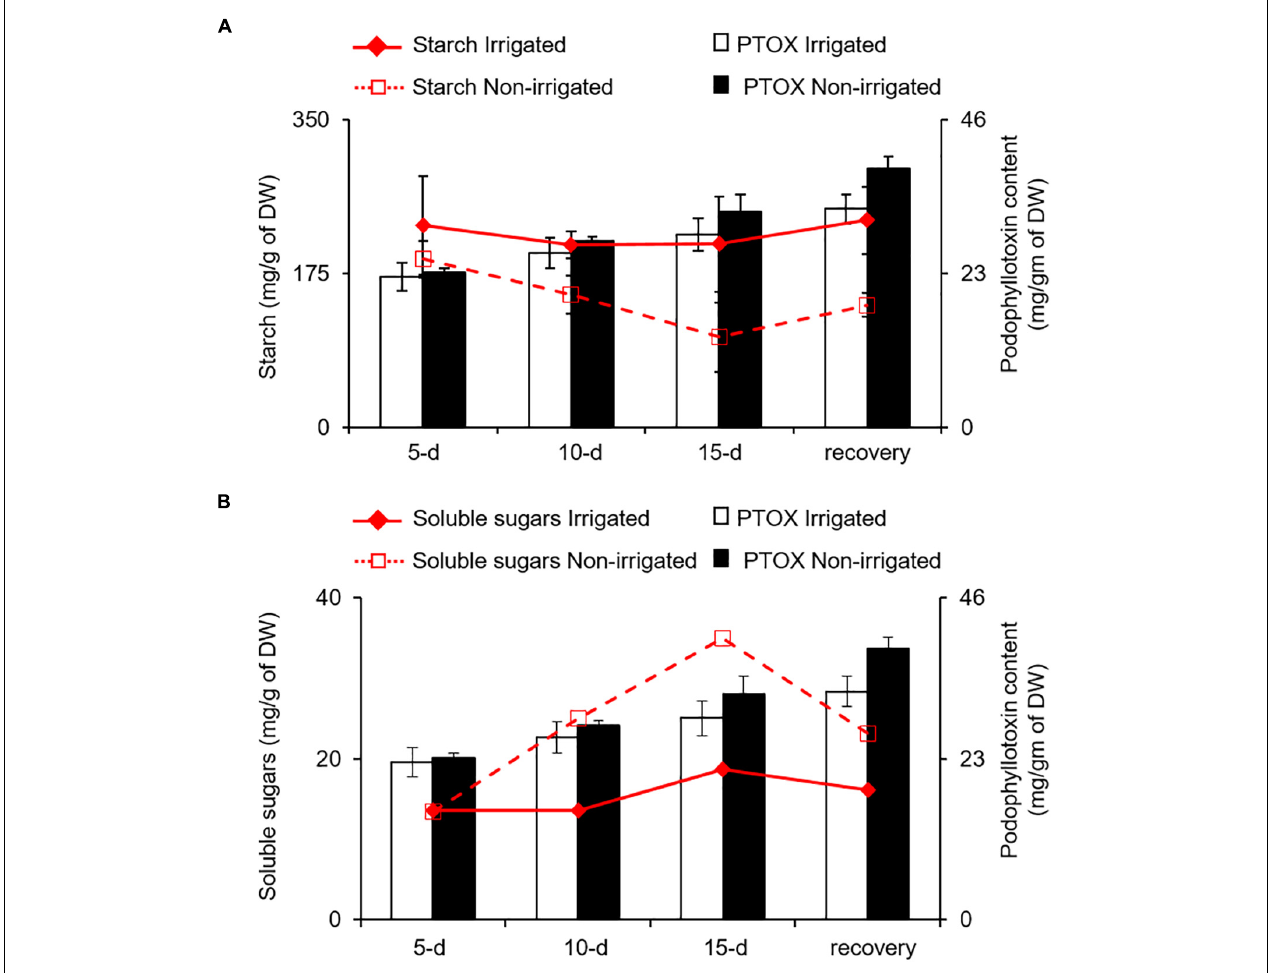
FIGURE 7 | PTOX content in the roots of S. hexandrum under water deficit conditions is coupled with starch and soluble sugars contents. Line and bar graph showing the change in PTOX accumulation with (A) starch and (B) soluble sugar contents. In panel (B) , soluble sugars represent the sum of inositol, glucose, and fructose in roots. The values represent the mean ± SE of three biological